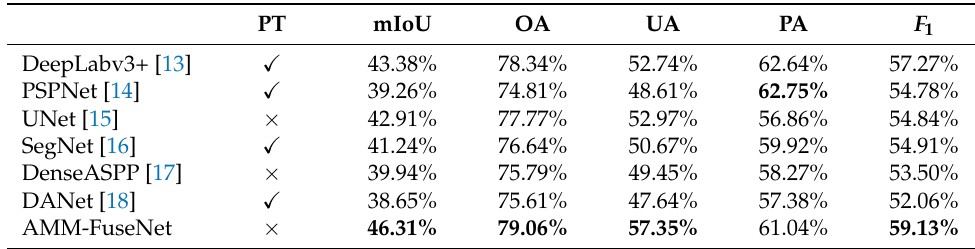
Table 6. Performance comparison for Hunan (Sentinel-2 and Sentinel-1) dataset. ( (cid:88) : pre-trained (PT) and × : not PT backbone).